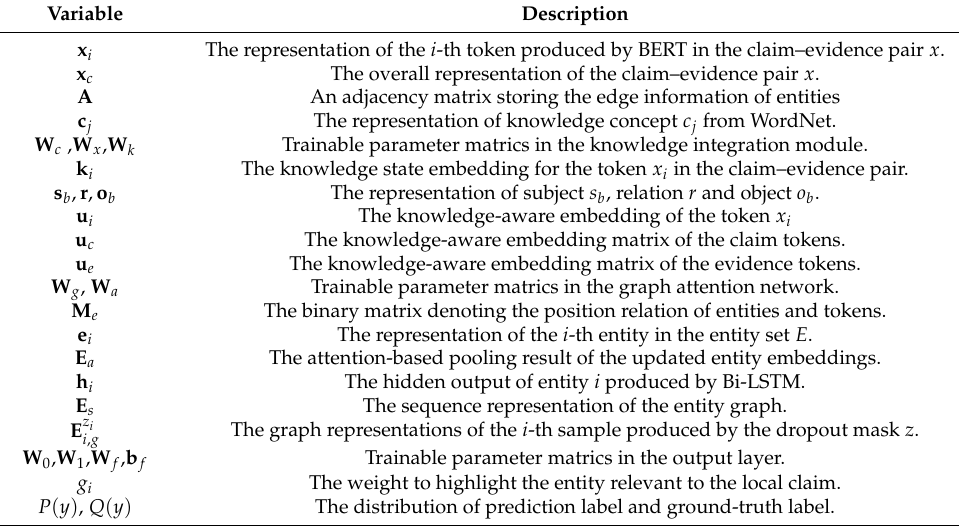
Table 1. Major notations used in this